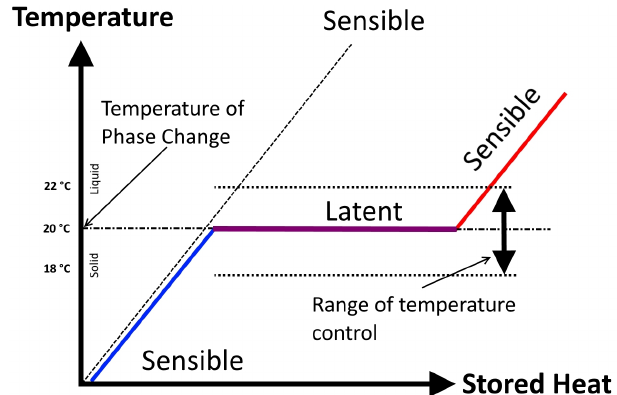
Figure 1. Sensible heat vs. latent heat and temperature control during the phase change [7].